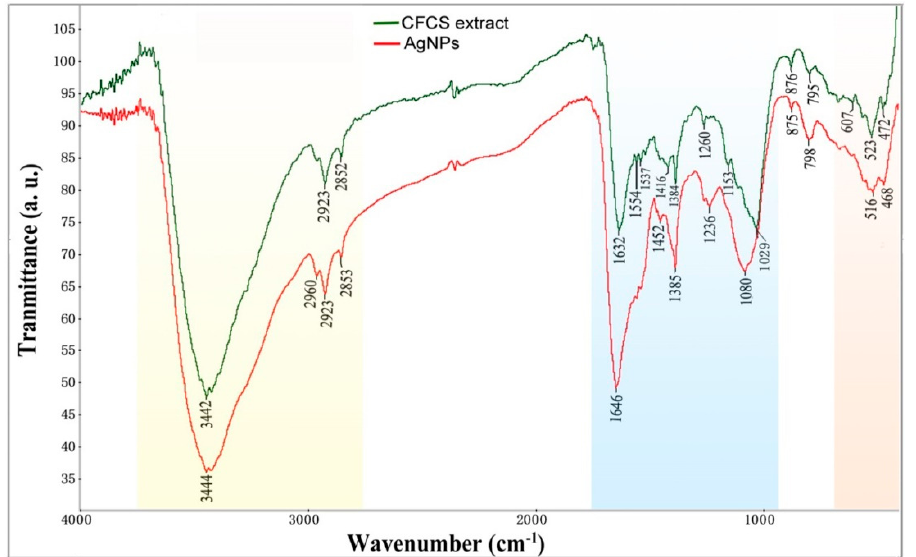
Figure 4. Characterization of the biosynthesized AgCl-NPs using cell-free culture supernatant extract of bacterial strain IMA13. FTIR of biosynthesized AgCl-NPs (red color), and cell-free culture supernatant of bacterium strain IMA13 dry (black color).